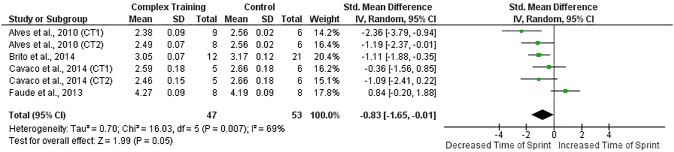
Standardized mean difference (SMD) in post-intervention sprint time between CT-trained and control subjects.Squares represent the SMDa for each trial. Diamonds represent the pooled SMD across trials.